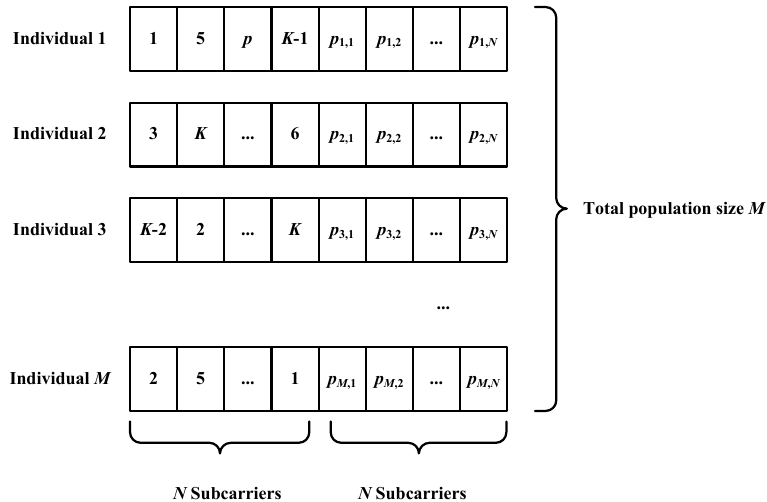
Figure 1. Structure of population and individuals designed for the power allocation